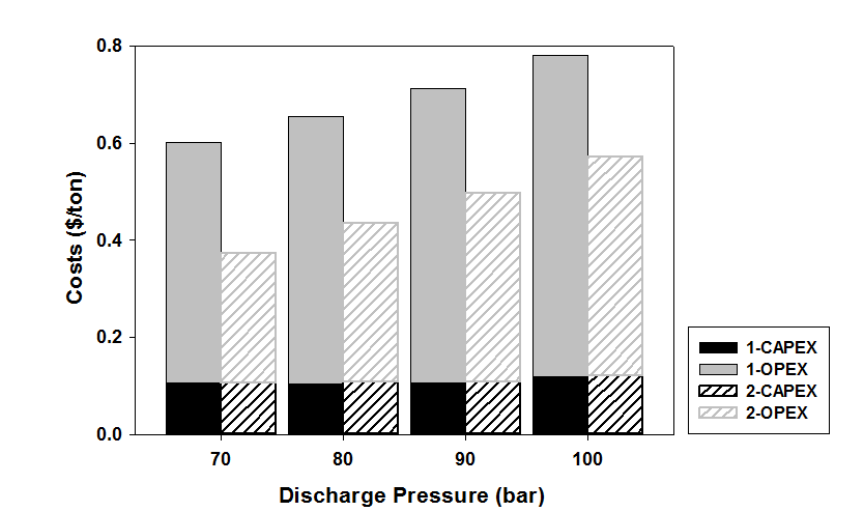
Figure 10. Life-cycle cost at different discharge